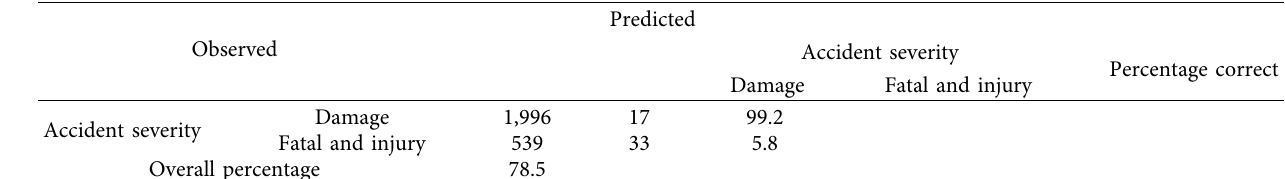
Table 10: Classification table in the logit model.